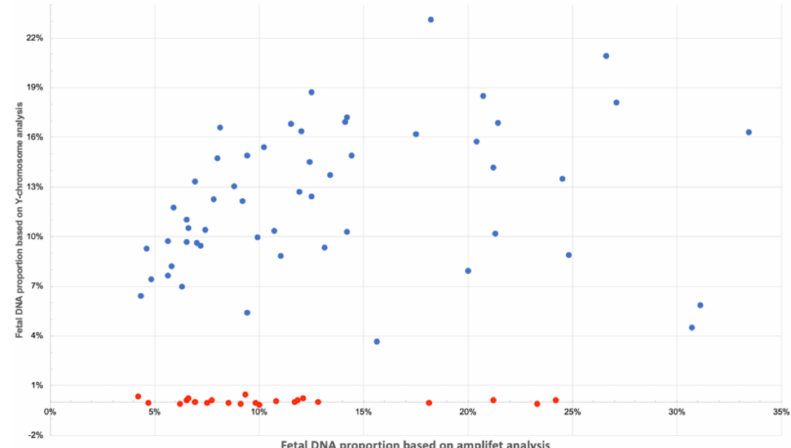
Figure 7. Fetal DNA proportion calculated for amplifet (X axis) and Y chromosome (Y axis). Male samples are indicated in blue, female samples in